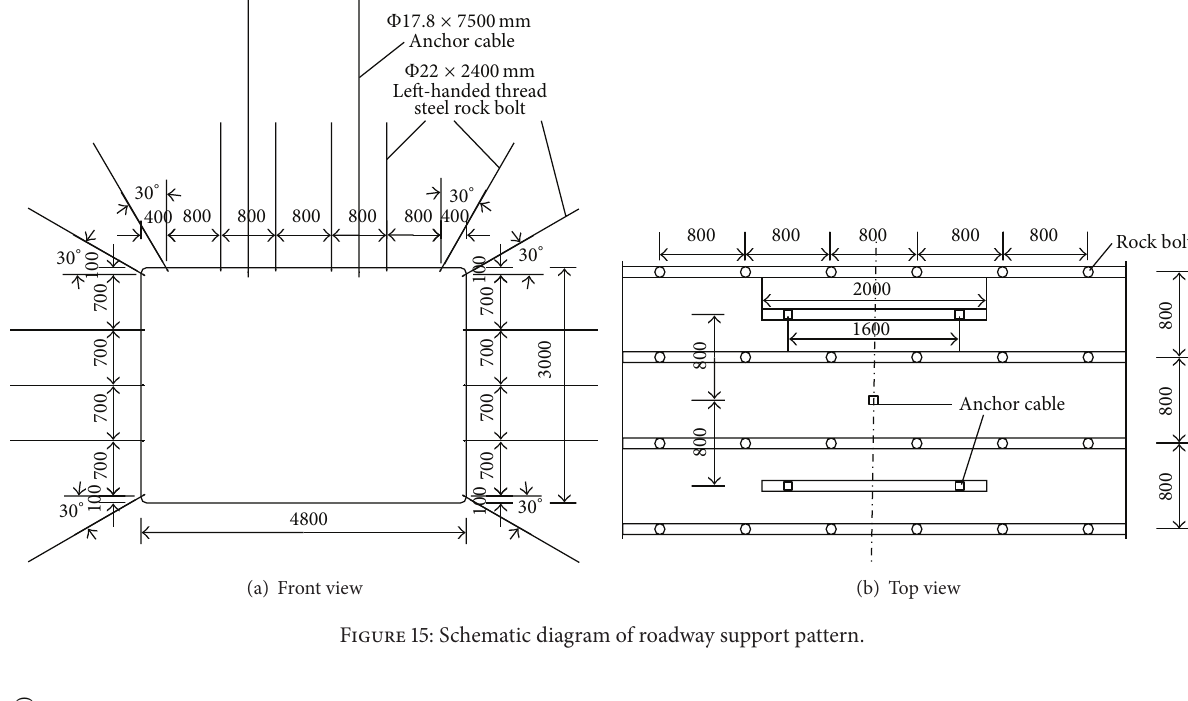
Figure 15: Schematic diagram of roadway support pattern.